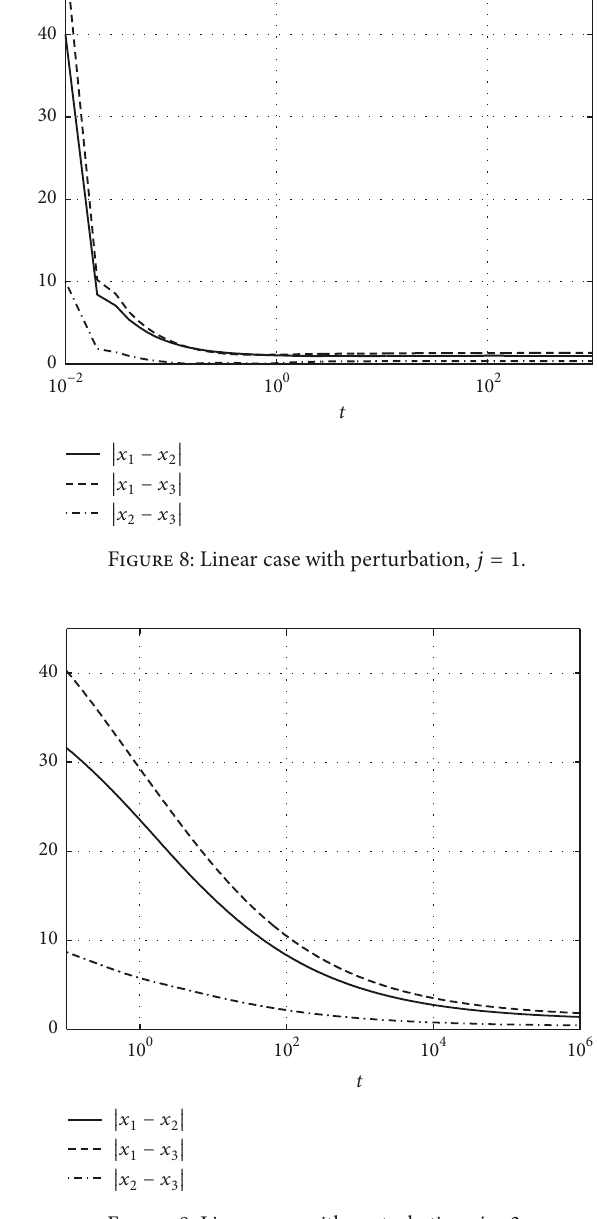
Figure 9: Linear case with perturbation, 𝑗 = 3